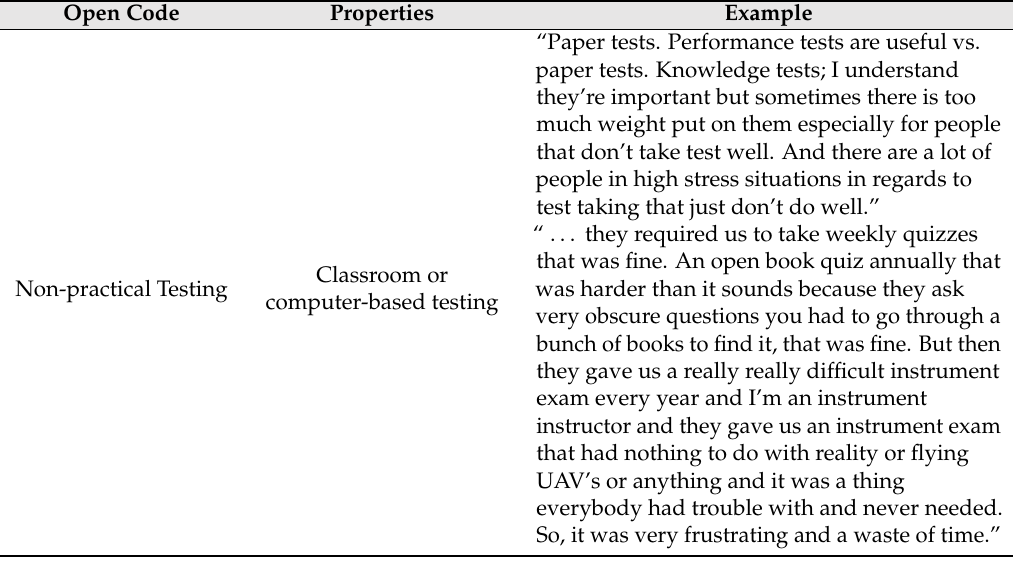
Table A4. Research Question: What aspects of training were lest